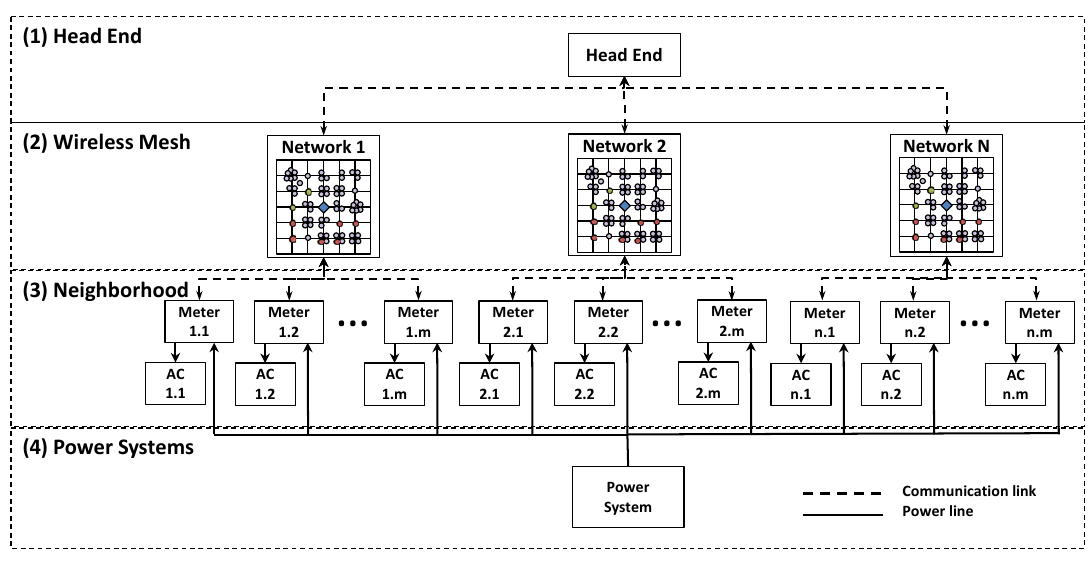
Figure 2. AMI model, that is used to communicate demand response (DR) commands to the air conditioning (AC) units, consists of four elements: (1) the Head End at the utility for smart meter management; (2) “n” Radio Frequency (RF) mesh networks of “m” smart meters each (colored circles) and a wireless router at the center (diamond); (3) a neighborhood model that defines meter and air conditioners; and (4) a model of the power system. Table 1. Neighborhood model of meter and air conditioner distribution (AC: air